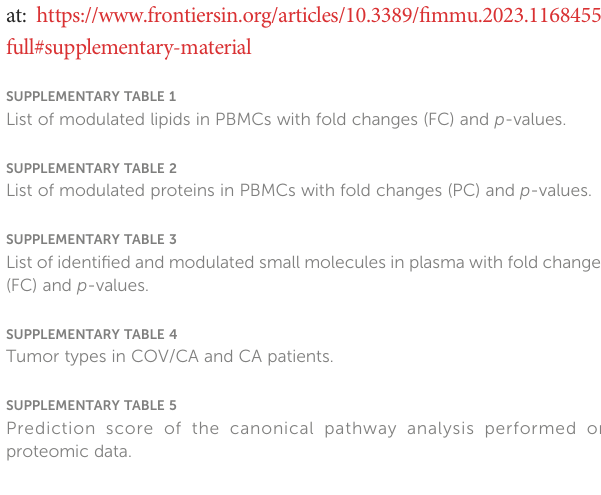
SUPPLEMENTARY FIGURE 4 Combined ROC of most relevant small molecule biomarkers. (A) Combined ROC of Oxalic acid and alpha-Tocopherol for the comparison between CA and COV/CA group; (B) Combined ROC of Arachidonic acid and alpha- Tocopherol for the comparison between COV and COV/CA patients; (C) Combined ROC of alpha-Tocopherol, 3-Indoleacetic acid, Arachidonic acid, Tryptamine and L-Tryptophan for the comparison between HD and COV patients. SUPPLEMENTARY FIGURE 5 Intracellular NAD + level variations express as fold change over the relative control in HD, CA, COV and COV/CA patients. Isolated PBMCs were cultured in RPMI media or stimulated with 100 µM Apigenin or 500 µM Leucine or 800 µM Nicotinamide for 1 h before intracellular NAD + quanti fi cation. HD ( n = 11), CA ( n = 6), COV ( n = 16) and COV/CA ( n = 5) patients. Statistical signi fi cance ofdifferencesbetween patientgroups wascalculatedusingTwo-wayANOVA with Sidak ’ s multiple comparisons test or one-way ANOVA followed by SUPPLEMENTARY FIGURE 6 (A) Representative fl ow cytometry gating strategy for the identi fi cation of major immune cell populations in blood. (B, C) Leucocyte gating strategy for phenotypic characterization of lymphocytes (B) and monocytes in PBMCs (C)